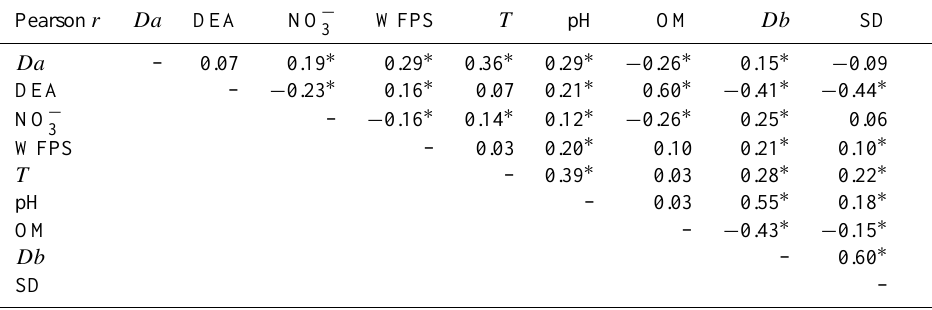
Table 2. Pearson r correlation coefficient. Statistical significance indicated by ∗ ( p < 0 . 05). Pearson r Da DEA NO −